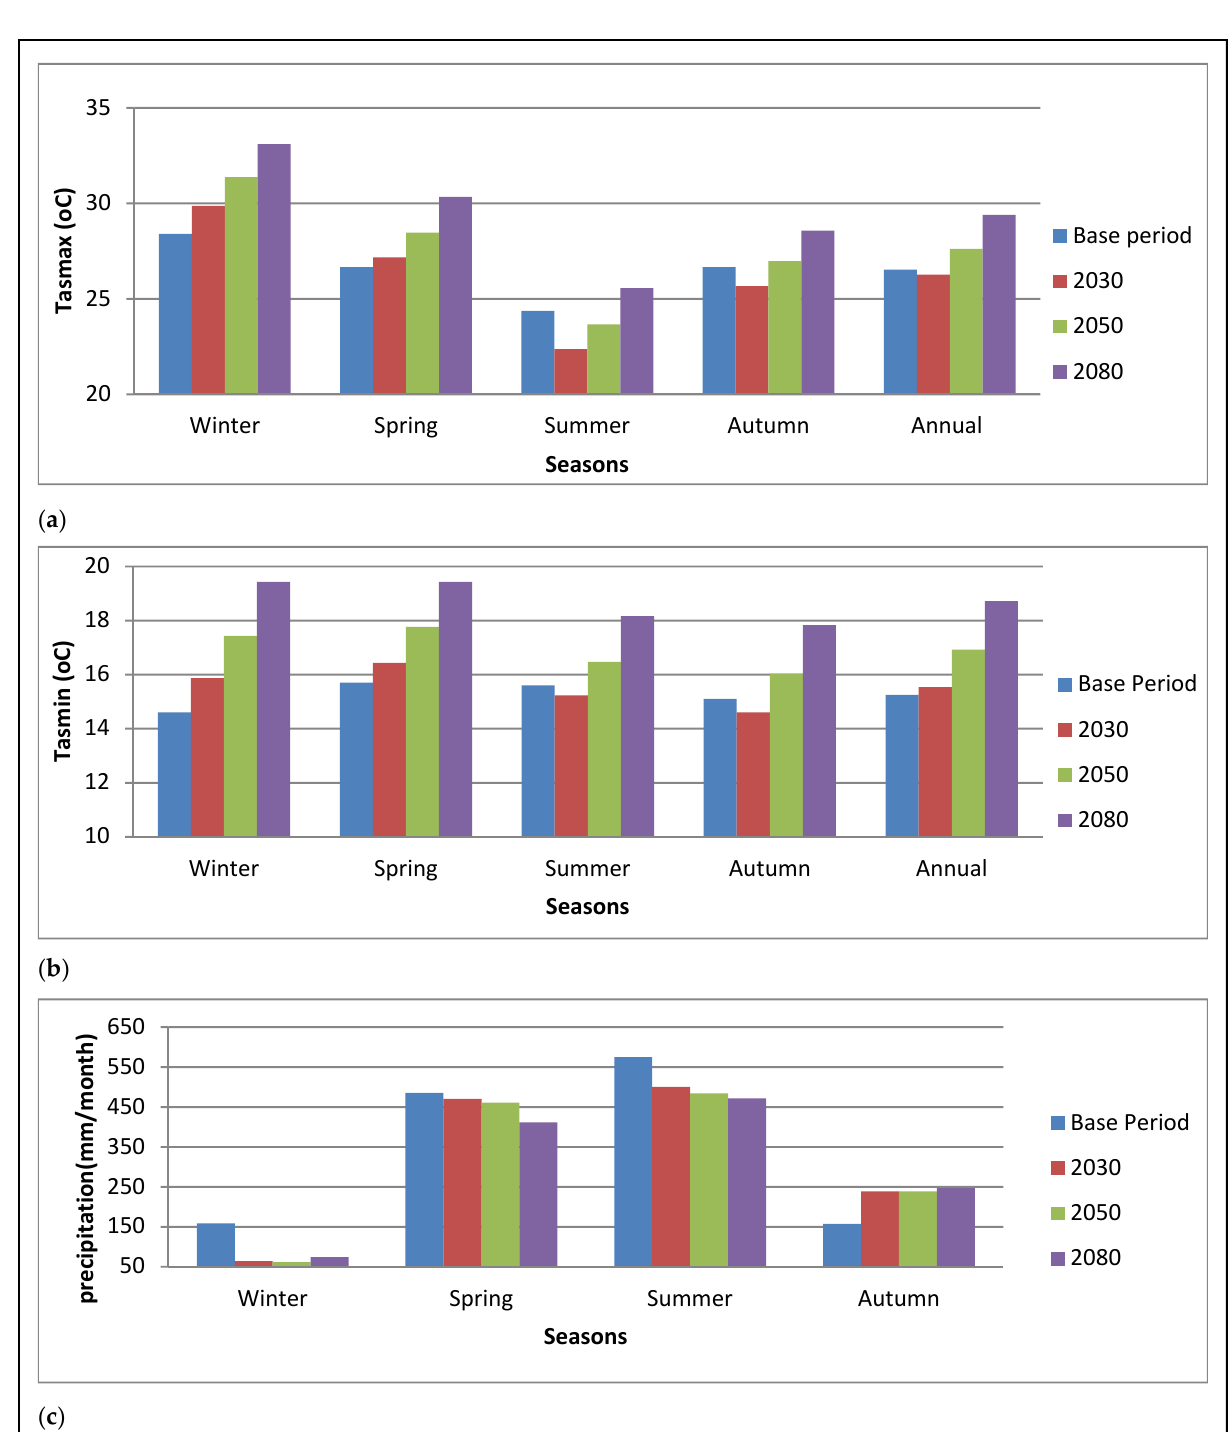
Figure 3. Projected ( a ) seasonal maximum temperature, ( b ) seasonal minimum temperature, and ( c ) seasonal precipitation under RCP8.5, as computed for the near-term (2030), mid-term (2050), and long-term (2080) with reference to the historical base period (1971–2005).